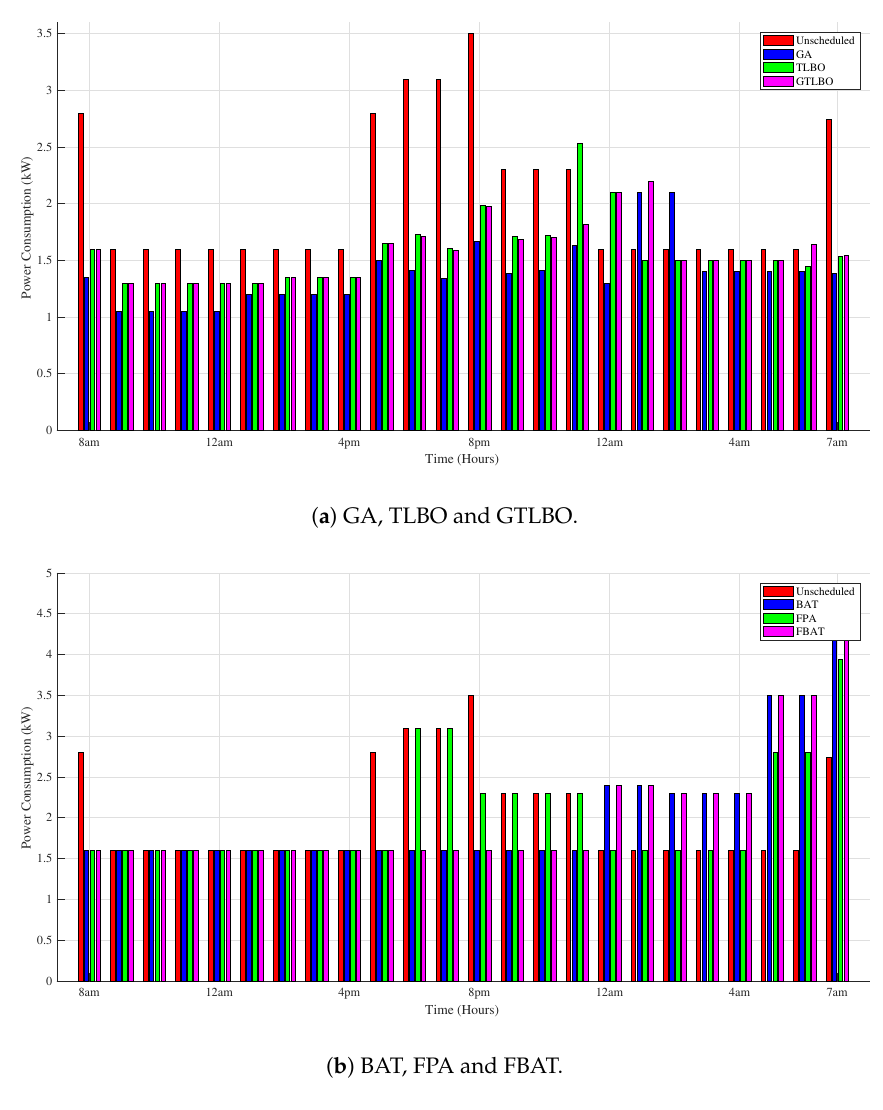
Figure 7. Hourly power consumption of appliances: ( a ) using GA, TLBO and GTLBO, ( b ) using BAT, FPA and